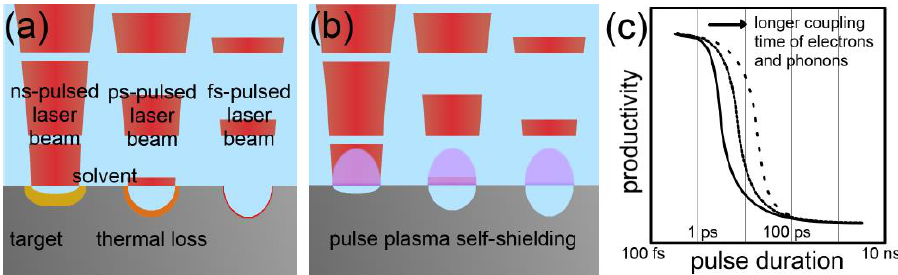
Figure 5. The effect of pulse duration on the laser ablation of a target in liquid ( a ) thermal loss, ( b ) pulse plasma self-shielding, and ( c ) NP productivity vs. pulse duration. [45].